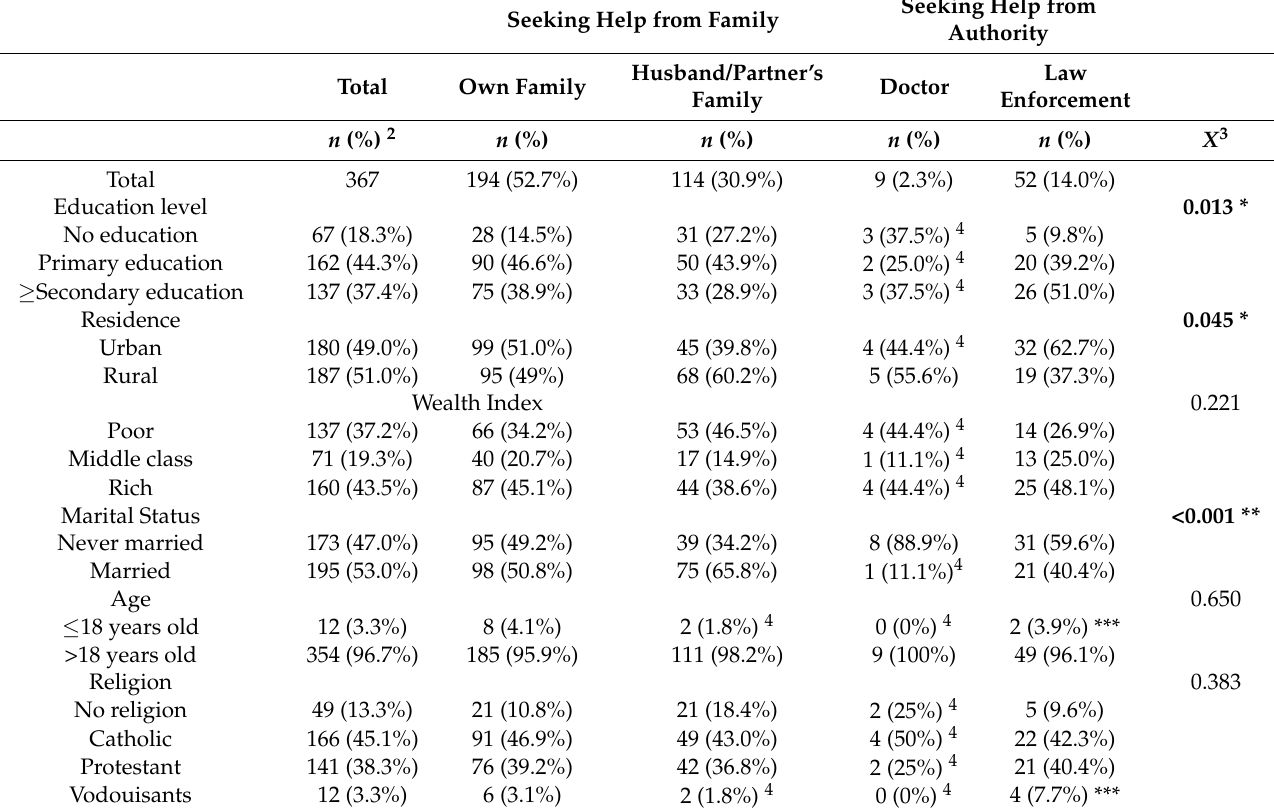
Table 2. Demographic characteristics of women who sought help for exposure to IPV 1